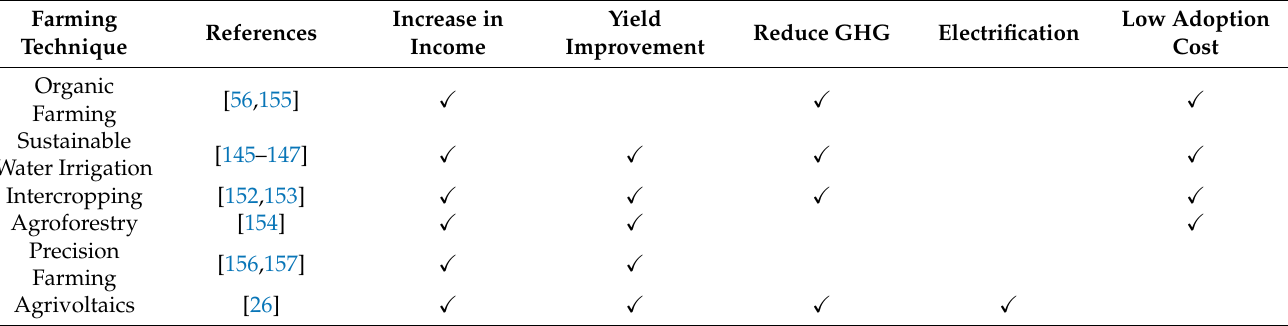
Table 2. Farming techniques for making agriculture